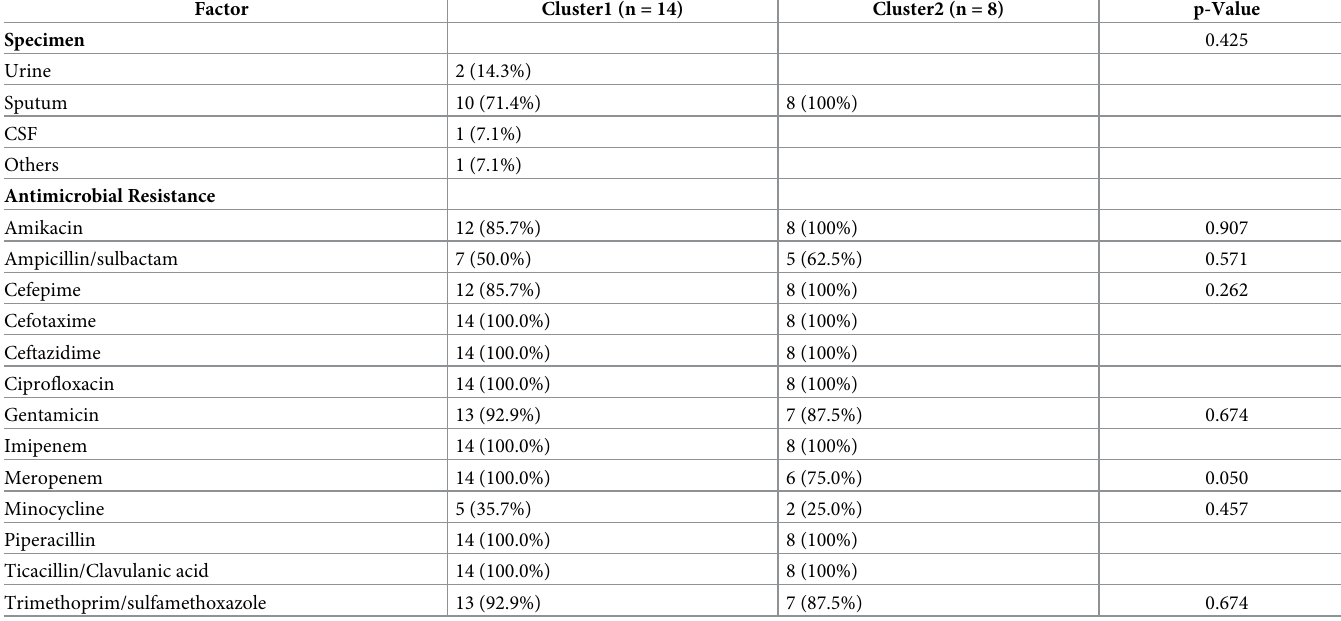
Table 3. Microbiologic characteristics of Cluster 1 and Cluster 2 according to whole-genome multilocus sequence typing